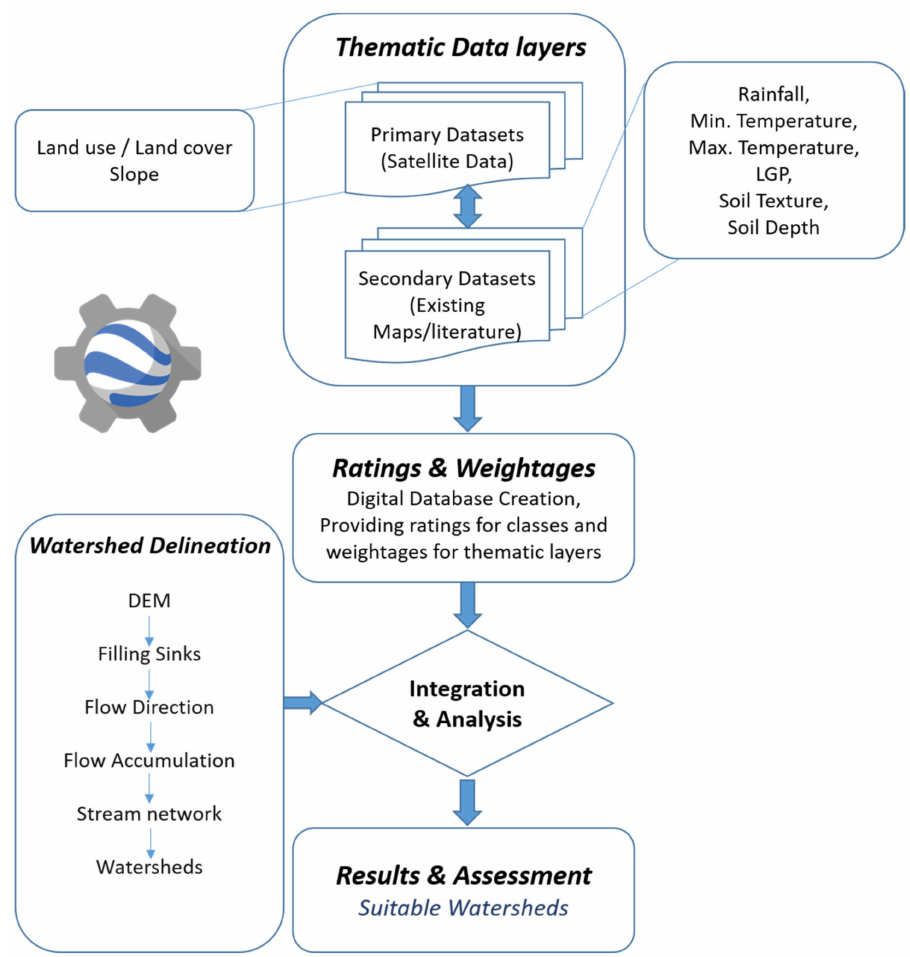
Figure 2. Methodology of watershed prioritization using geo-spatial layers.